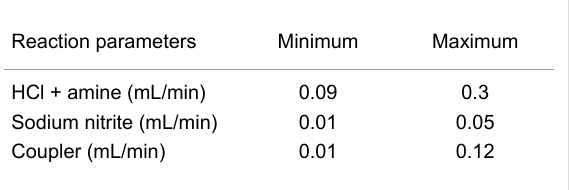
Table 10: Experimental